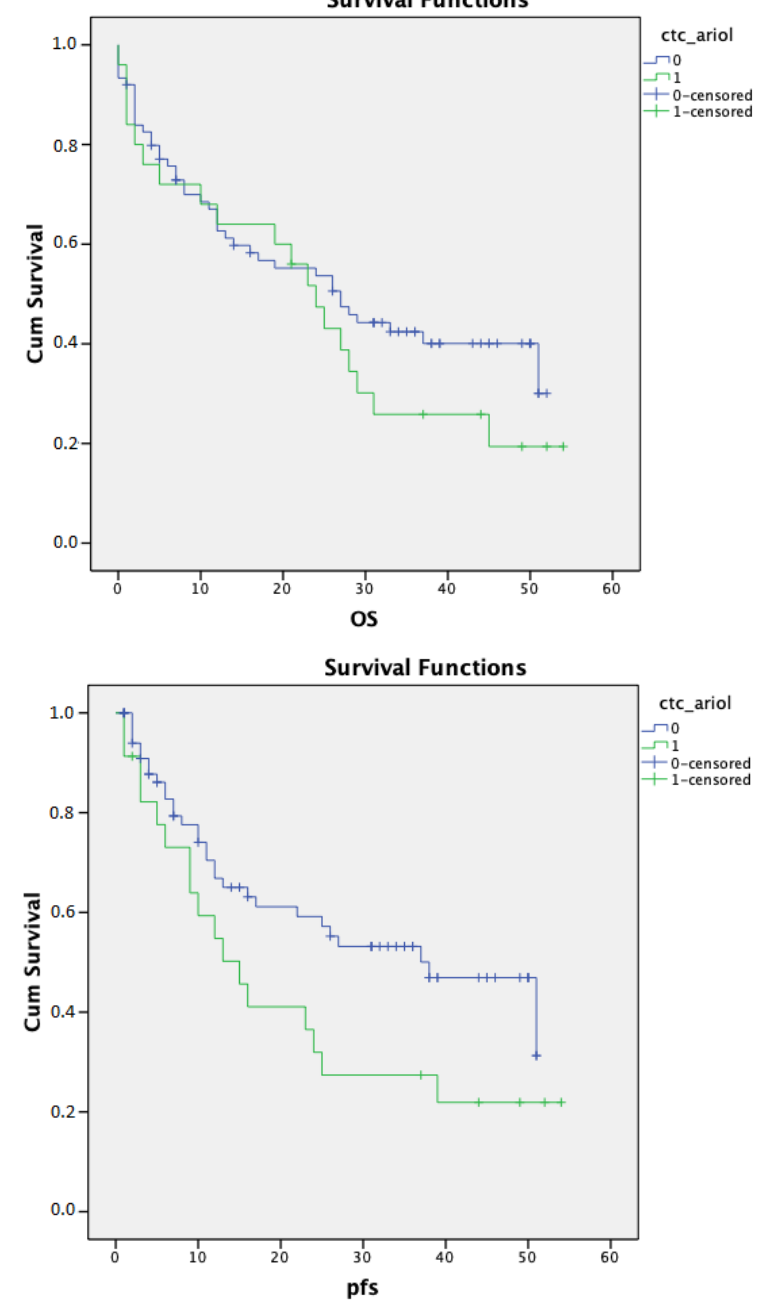
Figure 2. Kaplan–Meier curves for overall and progression-free survival according to ≥ 1 circulating tumor cell (CTC) detection by Magnetic Cell Separation (MACS) enrichment / Ariol. Patients with ≥ 1 CTC detected by MACS enrichment / Ariol did not show significantly shorter relapse-free ( p = 0.053) and overall survival ( p = 0.278) compared with CTC-negative